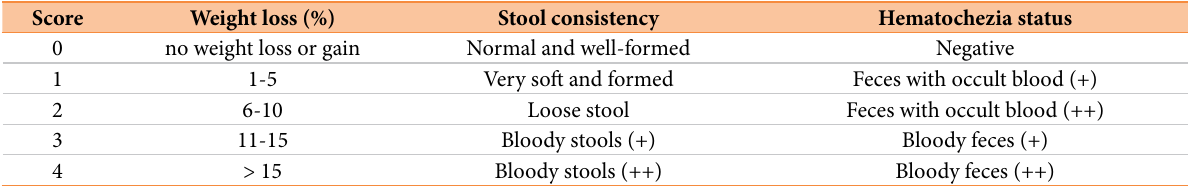
Table 1 - The scoring criteria of disease activity